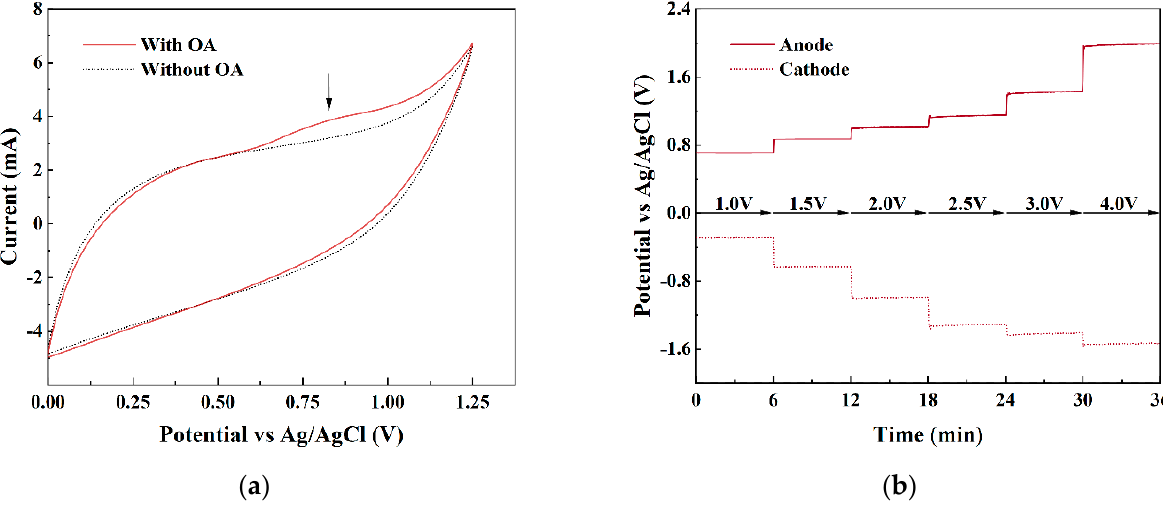
Figure 9. ( a ) CV curves of ECNFM-2.5%-1000 with or without OA; ( b ) anode and cathode potential as a function of applied voltage.